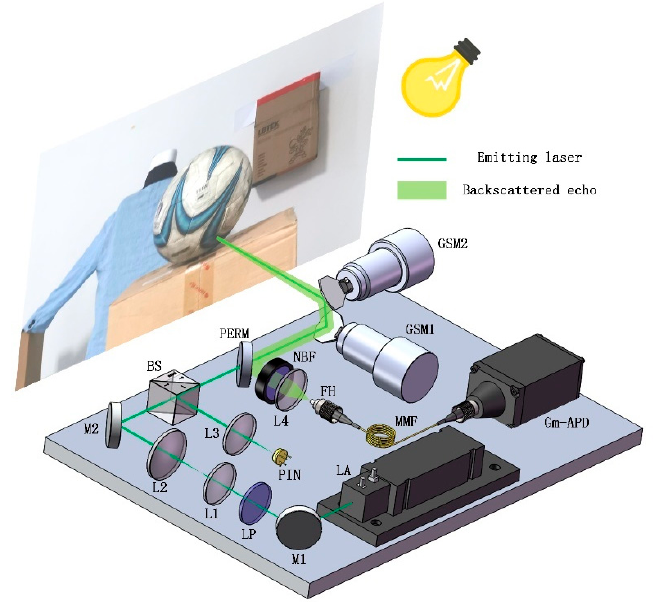
Figure 7. Illustration of our photon-counting experiment. LA, laser; M, mirror; LP, linear polarizer; L, lens; BS, beam splitter; PIN, pin photodiode; PERM, perforated mirror; NBF, narrow bandpass filter; FH, fiber head; MMF, multimode fiber; Gm-APD, Geiger mode avalanche photodiode; GSM, galvo scanning mirror. Scene of interest includes a mannequin, a football and a box.